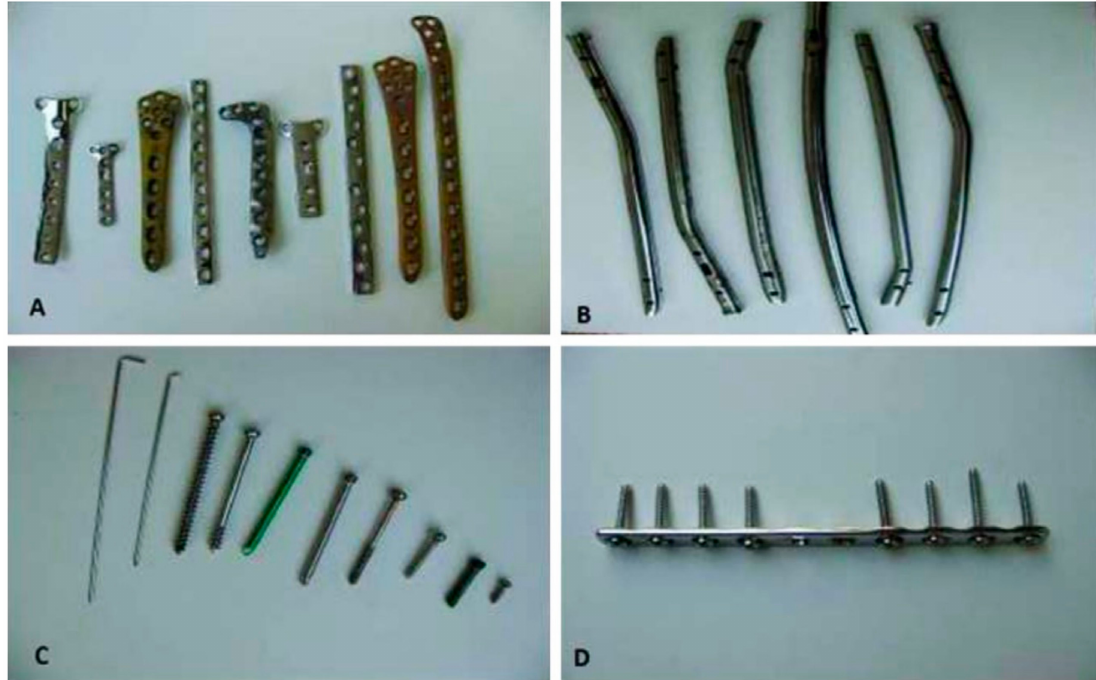
Figure 1. Different types of post-service metallic implants: ( A ) plates of stainless steel and titanium; ( B ) intramedullary nails of stainless steel; ( C ) screws and pins of stainless steel and titanium; ( D ) a plate with stainless steel screws